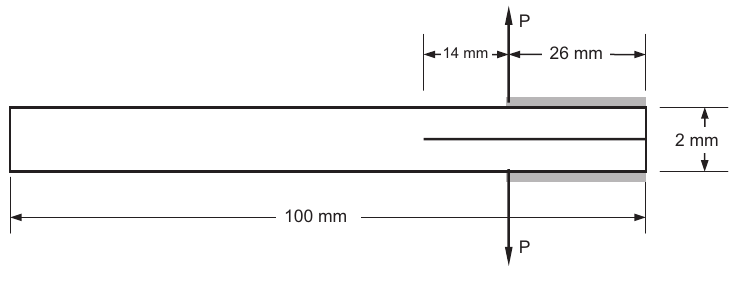
Figure 8 Specimen dimensions.